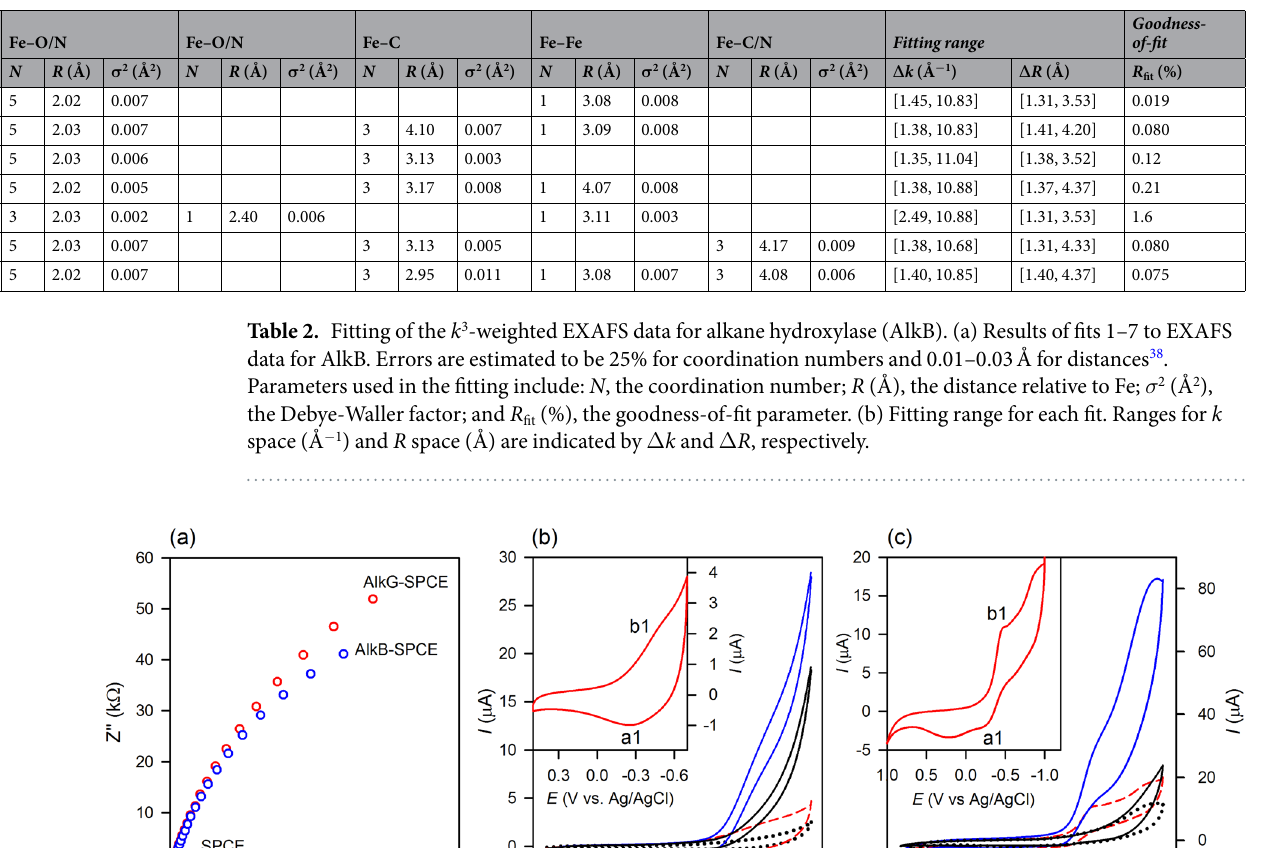
Figure 5. ( a ) Electrochemical impedance studies of AlkG modified SPCE, AlkB-enriched membrane SPCE, and bare SPCE in 1 mM [Fe(CN) 6 ] 3 − /0.1 M KCl solution. Electrochemical studies in 0.1 M phosphate buffer solution (PBS), pH 7.4: ( b ) cyclic voltammograms (CVs) of bare SPCE measured in the absence (black dotted line) and in the presence (black solid line) of oxygen; and CVs of AlkG-SPCE measured in the absence (red dash line) and in the presence (blue solid line) of oxygen. Inset: DET of AlkG-SPCE obtained in the absence of oxygen. ( c ) CVs of bare SPCE measured in the absence (black dotted line) and in the presence (black solid line) of oxygen; and CVs of AlkB-enriched membrane SPCE in the absence (red dash line) and in the presence (blue solid line) of oxygen. Inset: DET of AlkB-enriched membrane SPCE in the absence of